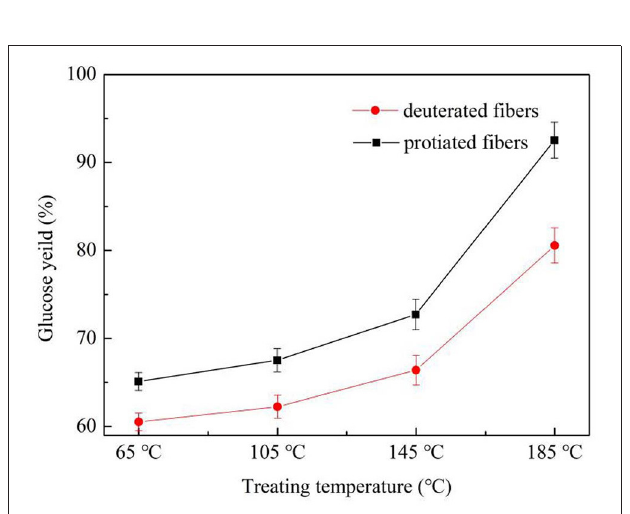
FIGURE 2 | Enzymatic hydrolysis glucose yield of deuterated cotton fibers and protonic cotton fibers (X ◦ C-fibers treated at X ◦ C).